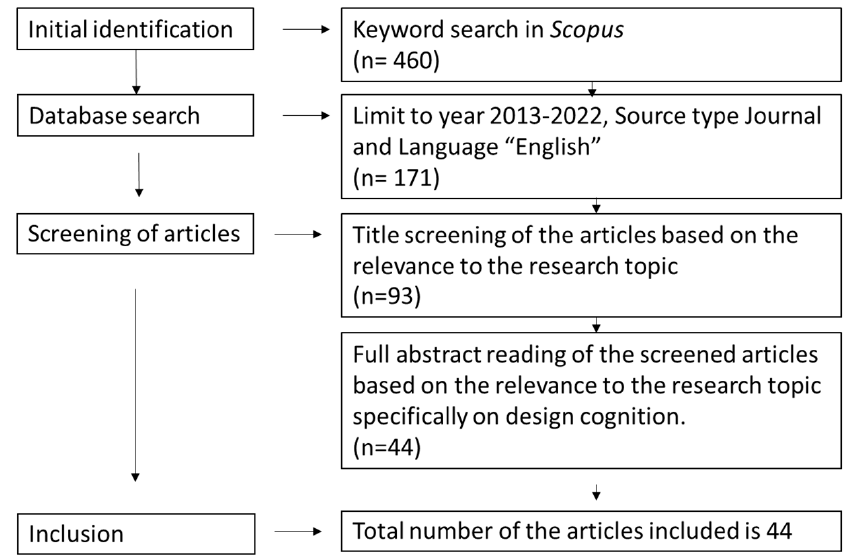
Figure 1. Article retrieval and selection process.